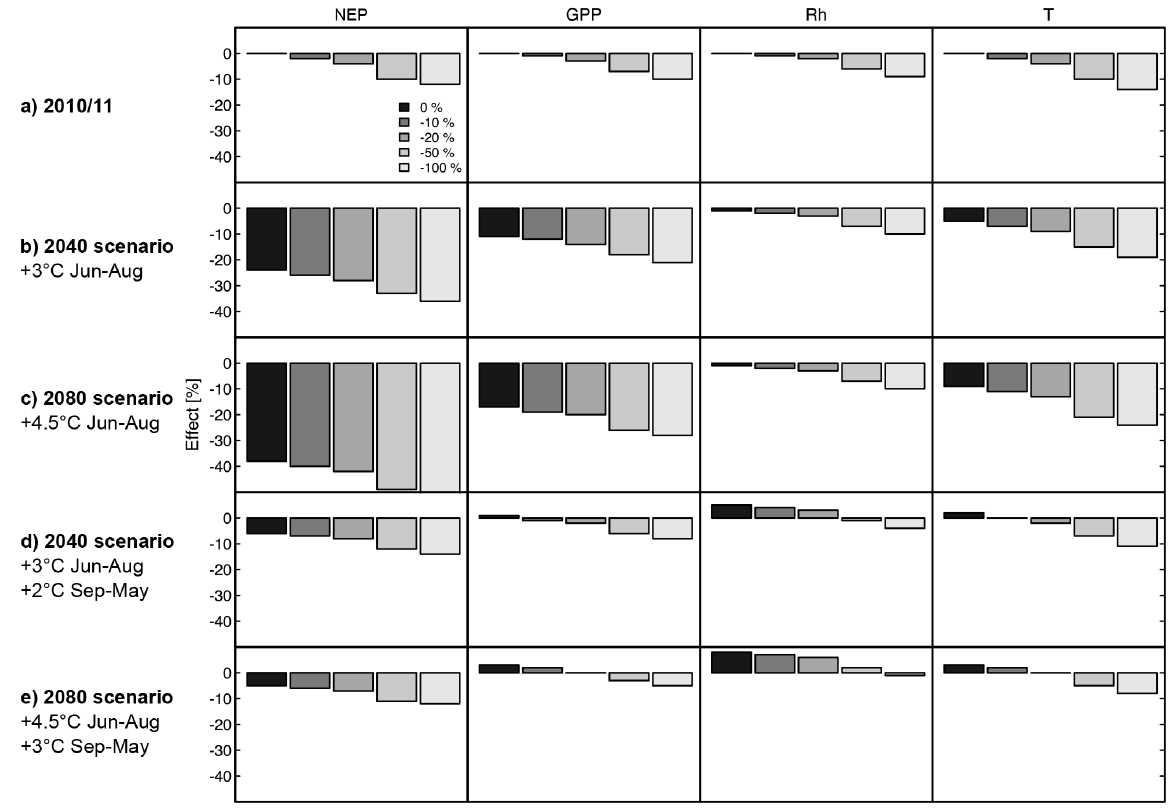
Figure 5. Effects of reduced precipitation and increased temperatures on simulated ecosystem fluxes. Percent mean annual changes of the 10yr model runs relative to the 2010/11 control conditions (0% rain reduction) are given. Precipitation from June to August was decreased by 0, 10, 20, 50 and 100% (10 and 20% reductions are in accordance with the climate scenarios for 2040 and 2080). 2010/11 control temperature (a) , only summer temperature increased (b) and (c) , all-seasons temperature increased (d) and (e) . Note that CO 2 concentrations were 390ppm for all